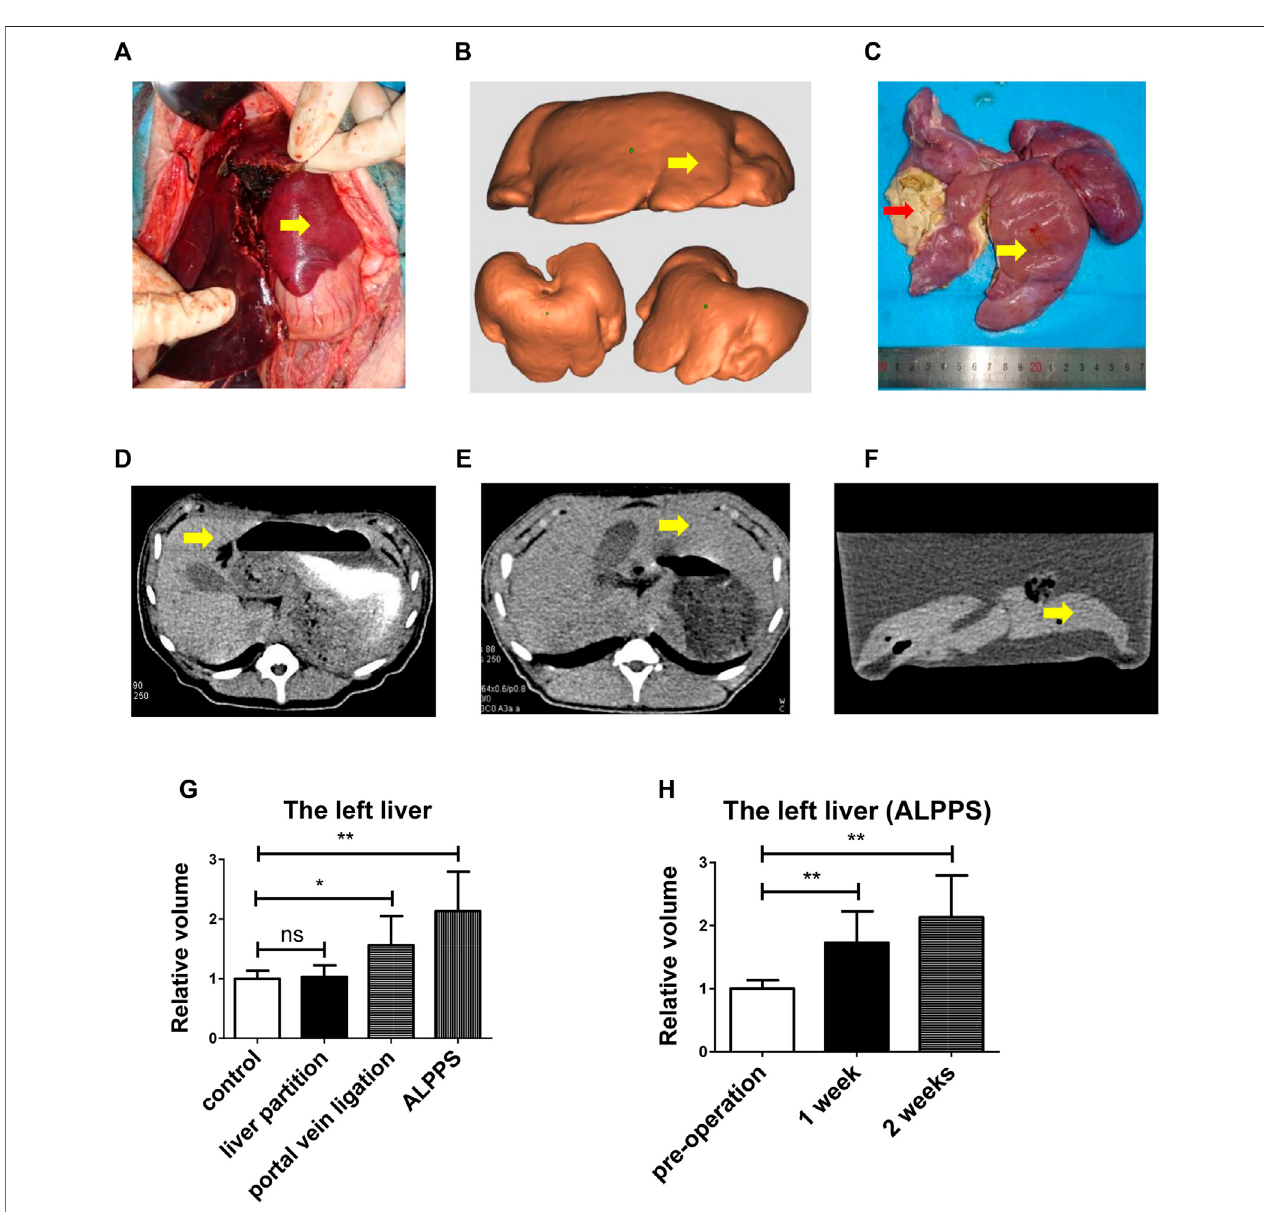
FIGURE2| ALPPScouldpromotepigliverregeneration. (A) ALPPSoperationonpigs,andtheyellowarrowindicatestheleftliver. (B) 3D-printedmodelofpigliver. (C) Pigsweresacri fi cedafter2 weeks;theleftliver(yellowarrow)andtherightliver(redarrow). (D) CTscanshowedtheliverbeforesurgery. (E)